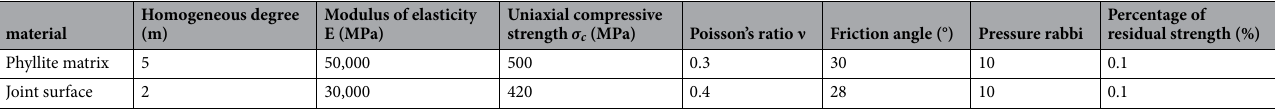
Table 2. Mesoscopic parameters of phyllite